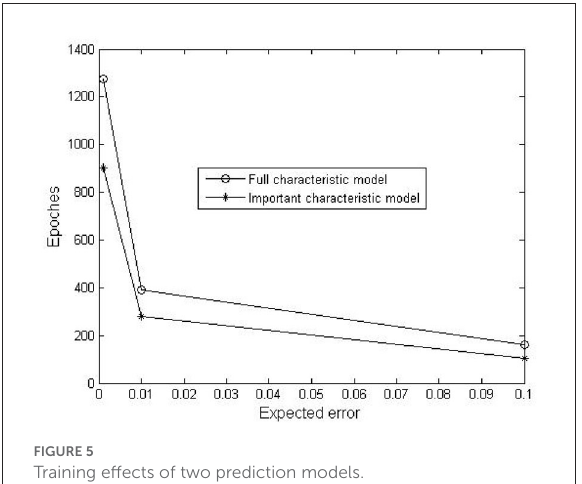
FIGURE5 Training effects of two prediction